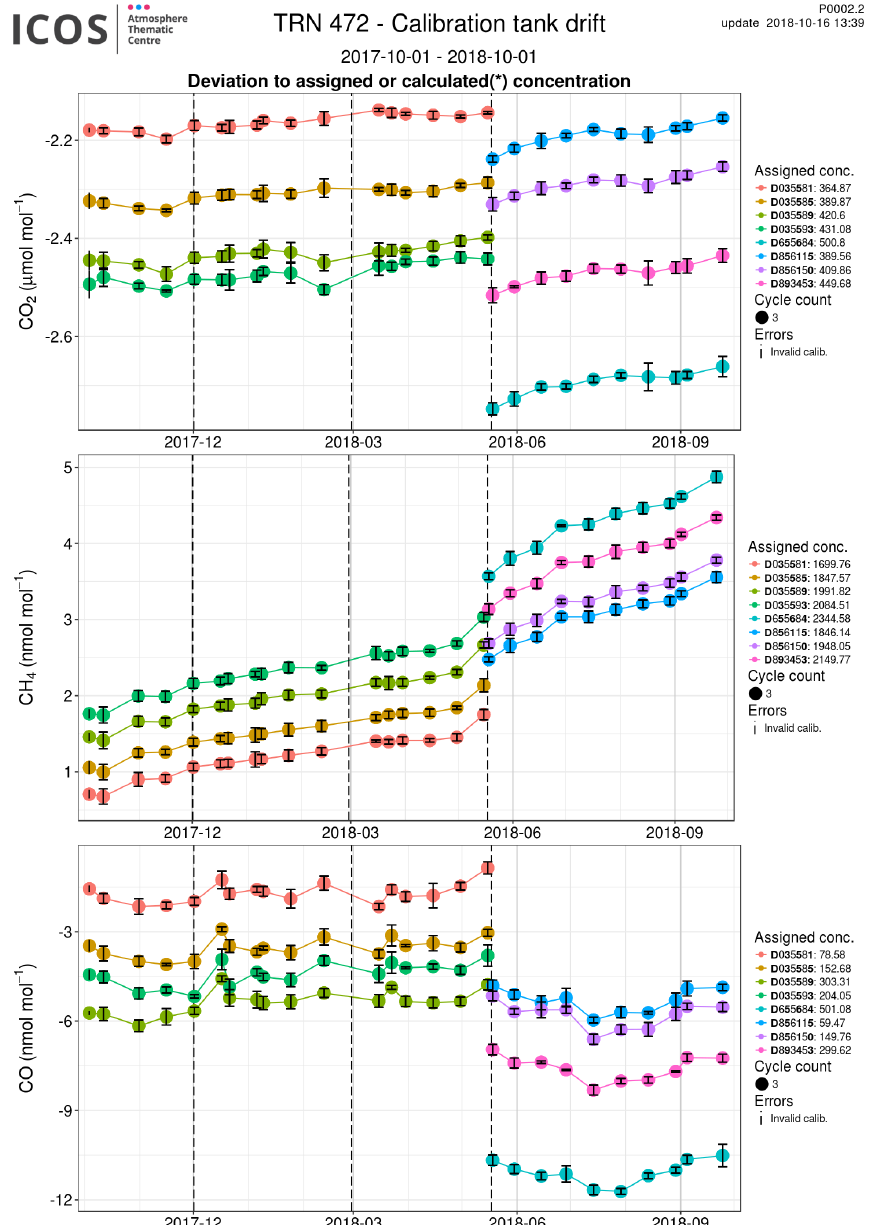
Figure 6. Evolution of the analyzer’s raw output when measuring different calibration gases with respect to the assigned values over a year at Trainou station (TRN) for instrument 472. Each calibration cylinder is shown with a different color. Assigned values are indicated on the right for each cylinder